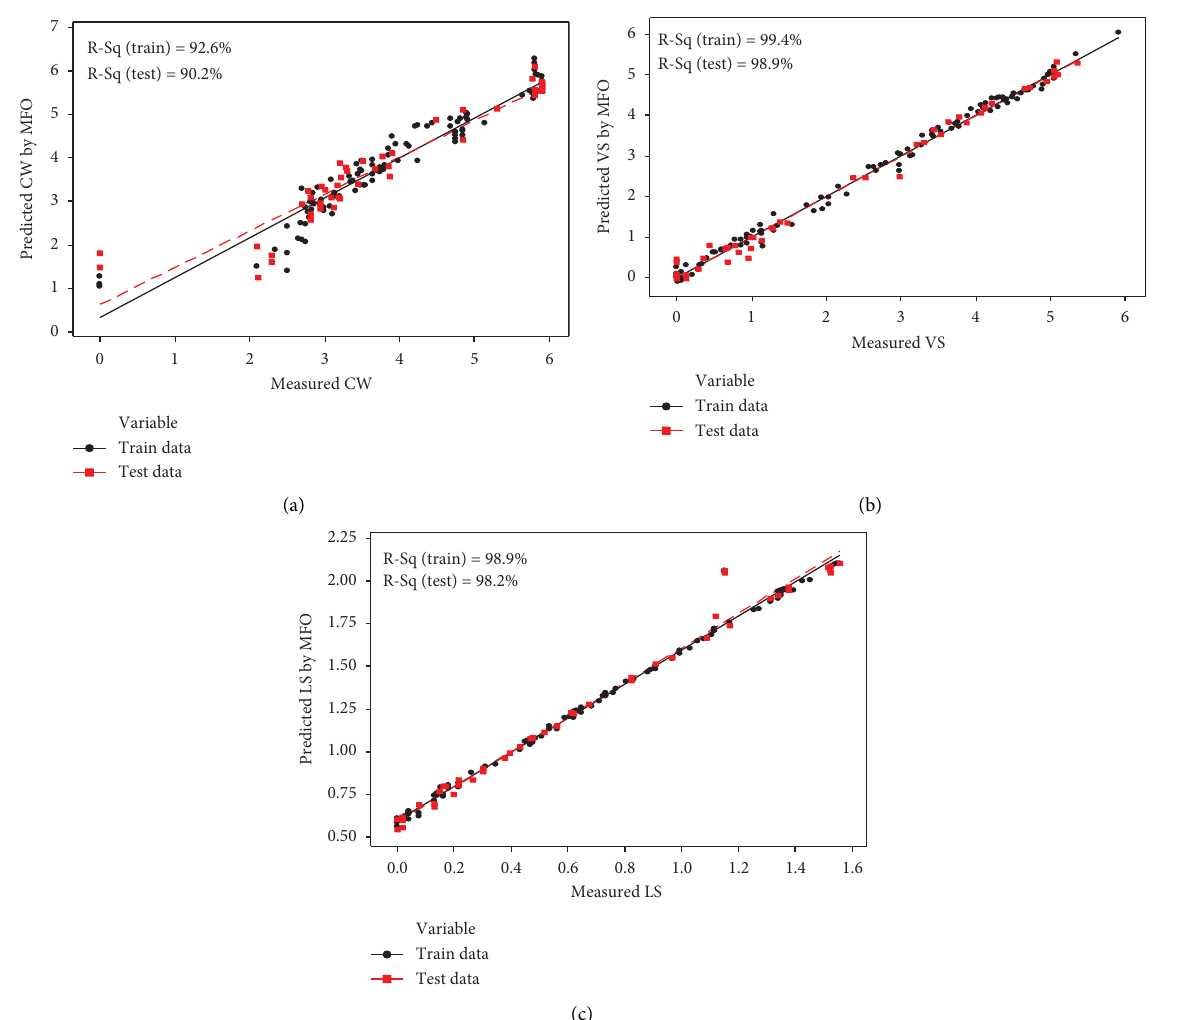
Figure 14: The values of R-squared for MFO models. (a) Crack width (CW), (b) volumetric shrinkage (VS), and (c) linear shrinkage (LS).